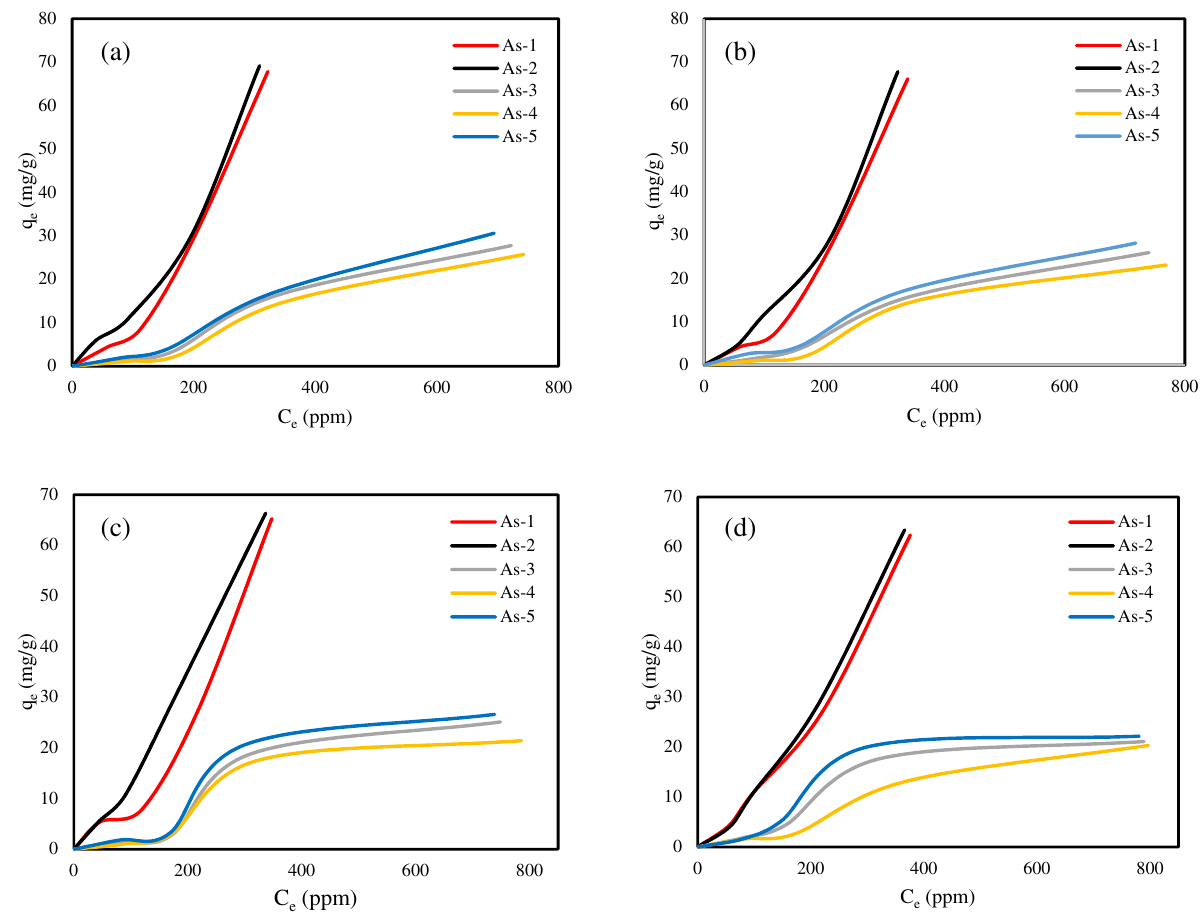
Figure 5. Isotherms of asphaltenes adsorption onto ( a ) magnetite NPs, ( b ) hematite NPs, ( c ) calcite NPs, and ( d ) dolomite